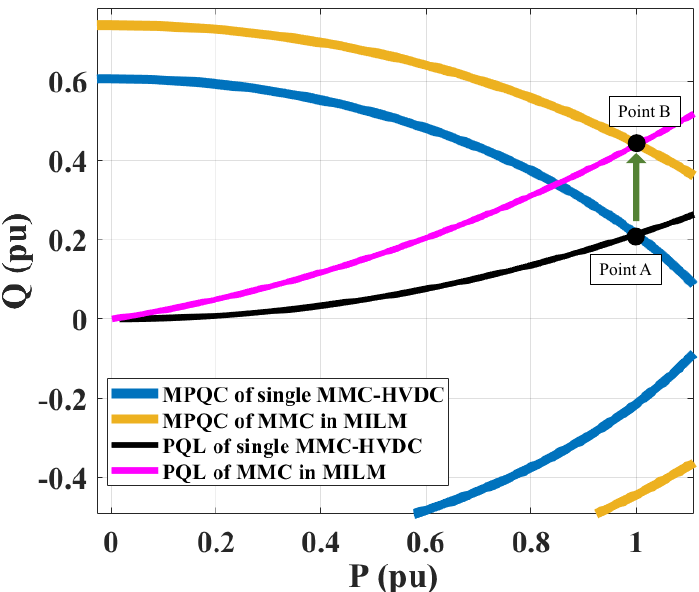
Figure 11. Steeper PQ loading curve in MILM causing higher requirement of